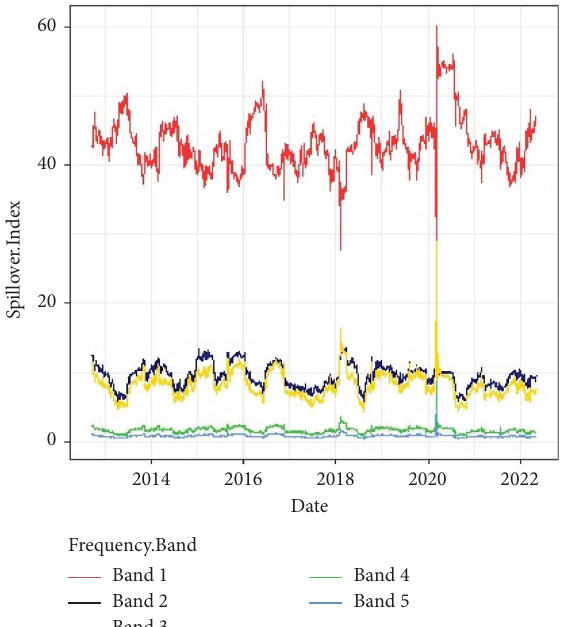
Figure 3: Dynamic return spillovers between regional Shariah markets. Notes: time- and frequency-domain return connectedness between Shariah regional markets is presented. Band 1 (red colour) represents short-term dynamics, Bands 2 (navy colour) and 3 (gold colour) depict the medium term, while the long-term dynamics are shown by Bands 4 (lime green) and 5 (cornfower blue). Te horizontal axis displays the time domain, while the spillover indices (in %) are plotted against the vertical axis for the respective frequency